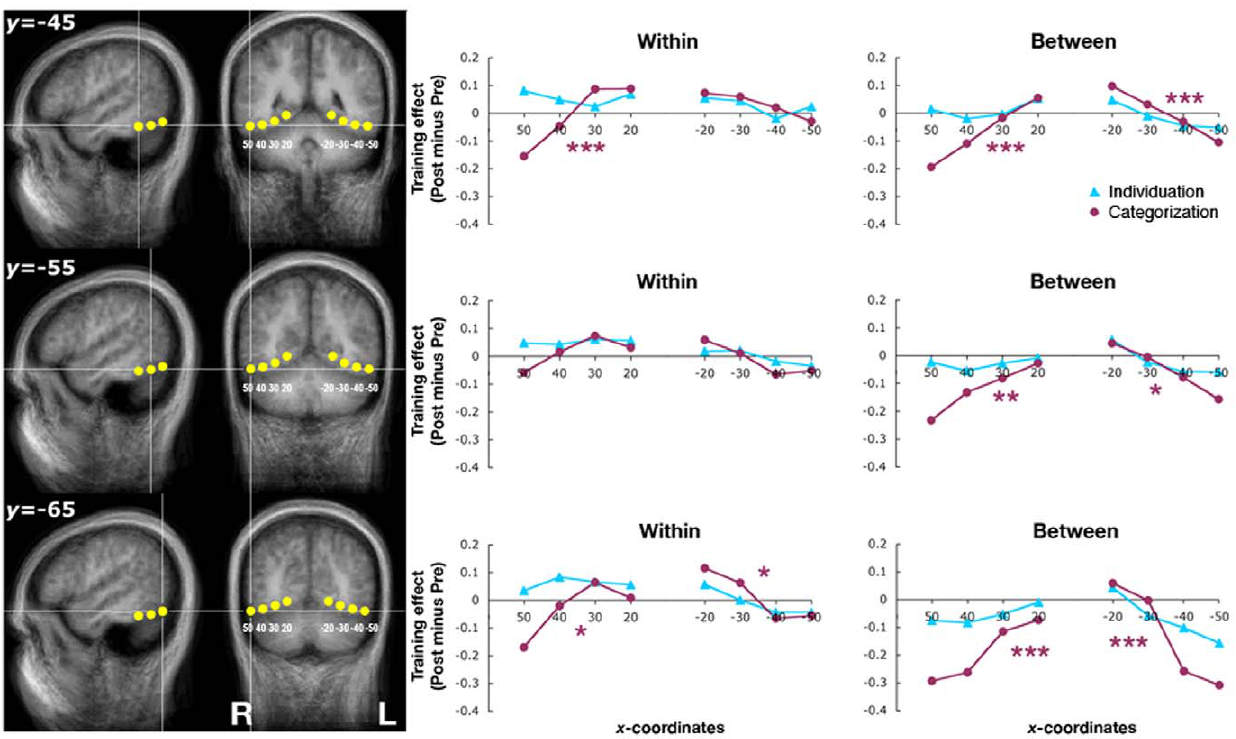
Figure 4. Training effects for the ventral occipito-temporal regions. The categorization group showed increased activity for the Ziggerins in the medial regions and decreased activity at the lateral regions after training, as indicated by the significance of the linear trends within each hemisphere ( p , .05, .01, and .001 indicated by one, two, and three asterisks respectively). The individuation group did not show any reliable pattern of changes. The brain was depicted with a radiological convention (i.e., left hemisphere one the